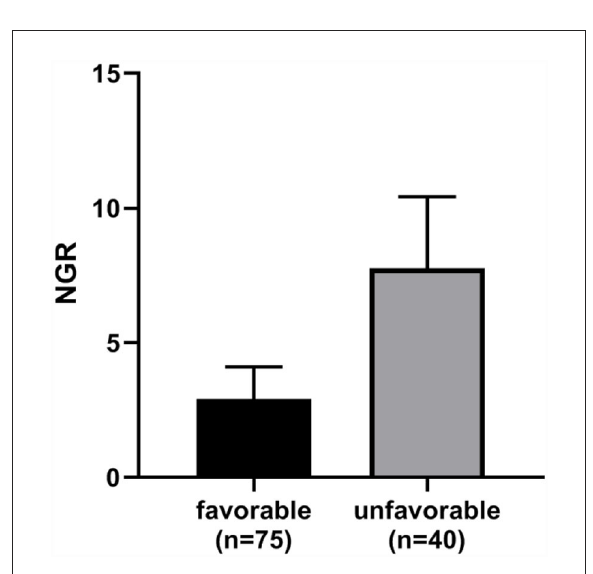
FIGURE4 The NGR of the favorable outcome group was significantly lower than the unfavorable outcome group ( p < 0.0001). Error bars indicate interquartile range. NGR, serum NSE level to admission GCS score